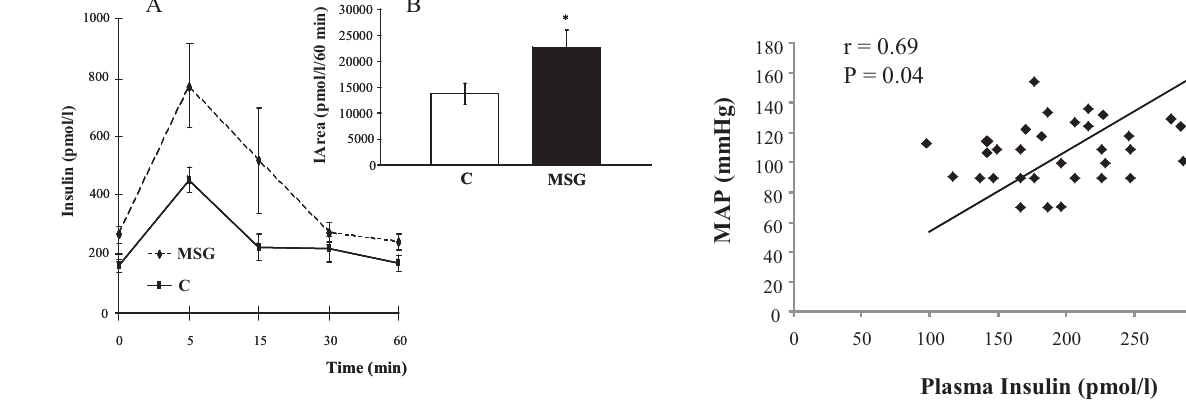
Figure 2 - Correlation between plasma insulin and mean arterial pressure (MAP) in the control (C) and monosodium glutamate- treated (MSG) rats (r=0.69, p=